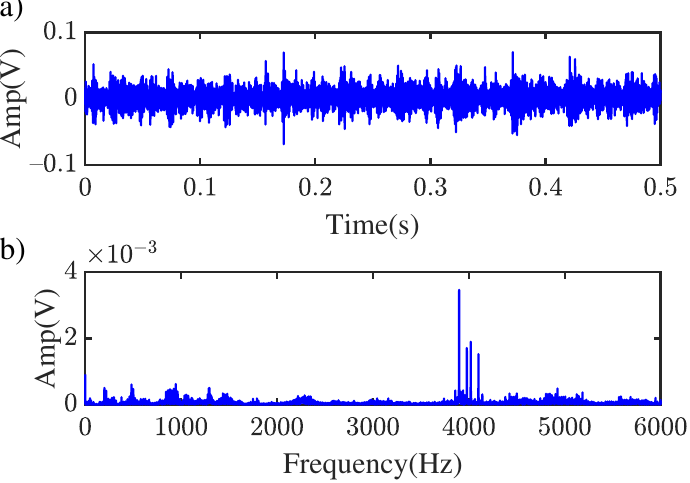
Figure 15. Vibration signal of inner raceway defective bearing: ( a ) time waveform; ( b ) Fourier